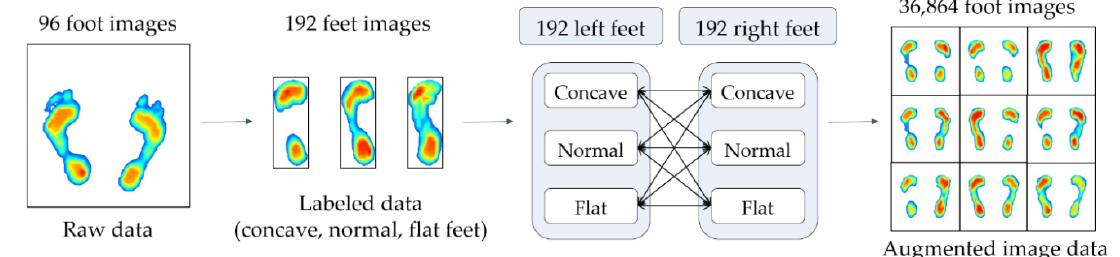
Figure 8. Data augmentation method.